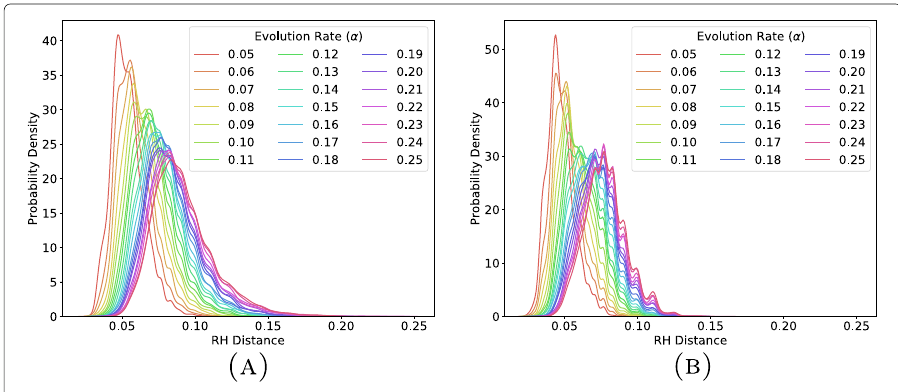
Fig. 4 Distribution of RH distance under HLM evolution. a Power-Law. b Bump Power-Law